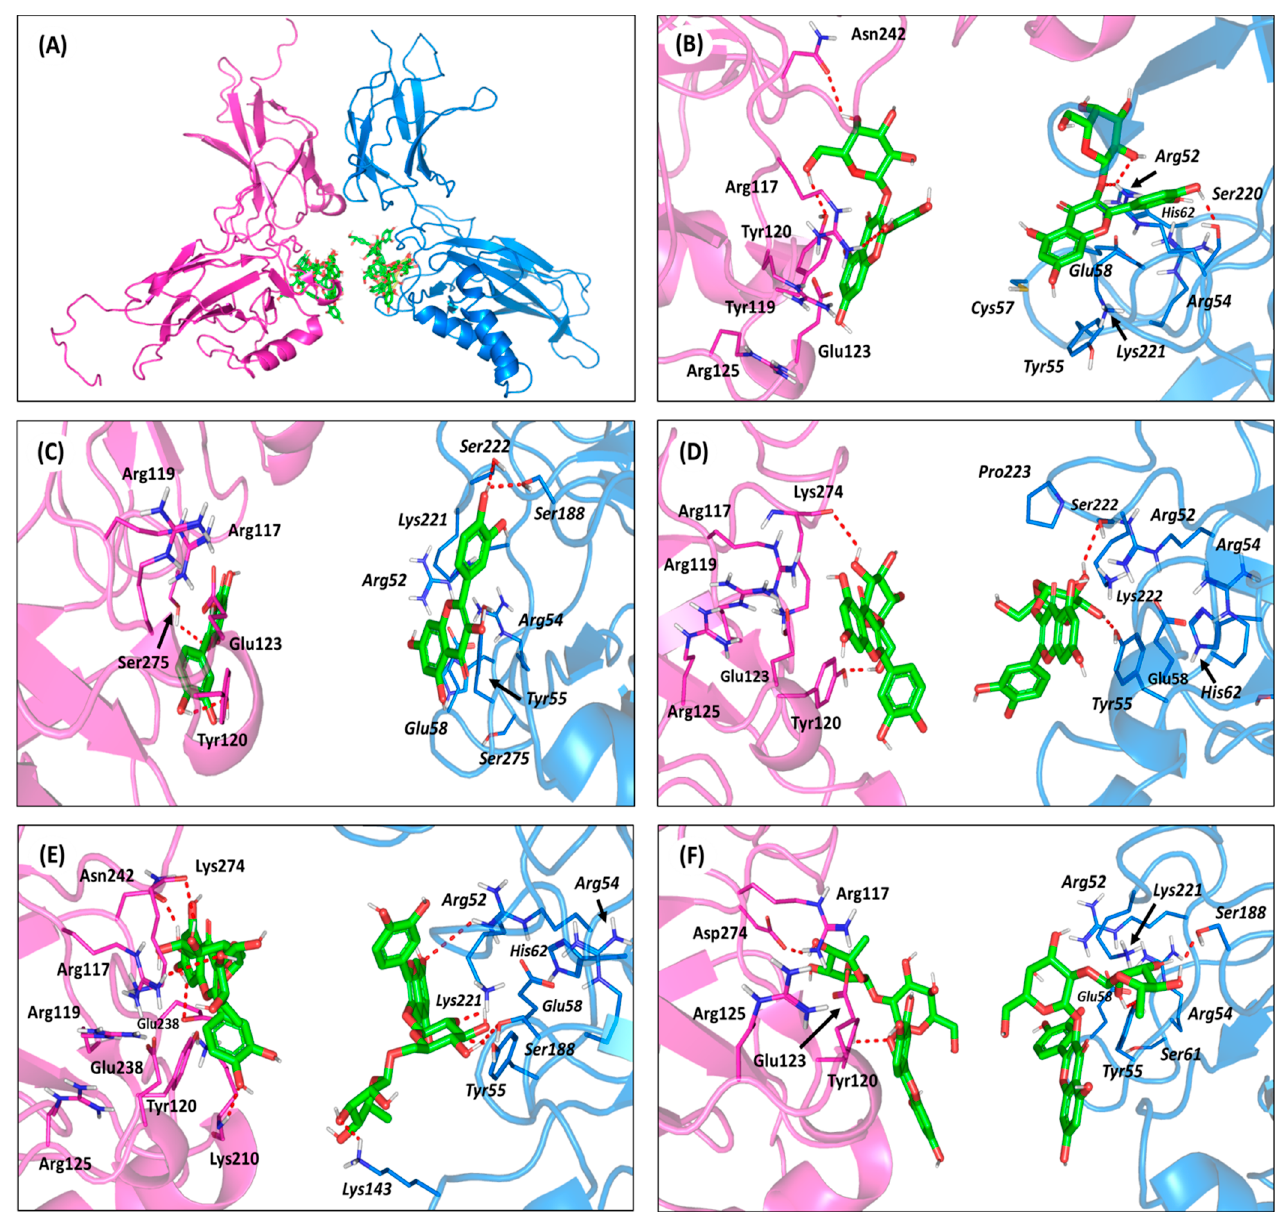
Figure 7. Molecular docking investigation of the isolated compounds at DNA-binding domains of the NF- κ B RelB:p52 heterodimer (PDB ID: 3DO7). ( A ) An overlay of the docked ligands (green sticks) at both NF- κ B heterodimer subunits, RelB (magenta cartoon) and p52 (marine blue cartoon). ( B – F ) The predicted binding modes of quercetin-3- O - β -galactoside ( B ); quercetin ( C ); isoquercitrin ( D ); rutin ( E ); and quercetin-3- O -neohesperdoside ( F ) at RelB (left side) and p52 (right side) illustrated as cartoon 3D-representation within their respective magenta and marine blue colors. Polar interactions, represented as hydrogen bonds, are illustrated as red dashed lines and only residues (lines), located within a 4 Å radius of bound ligand, are displayed and labeled with sequence number.